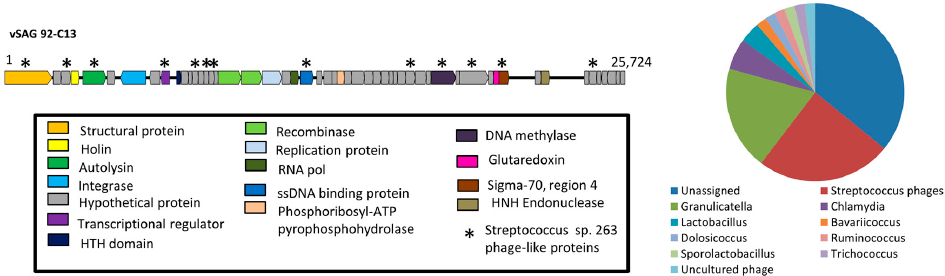
Figure 2. Genome annotation of the sorted single virus vSAG 92-C13. Conserved ORFs within Streptococcus phages are indicated with asterisk (*). The pie chart depicts the closest genera hits of the annotated proteins of vSAG 92-C13 (see Methods for details).